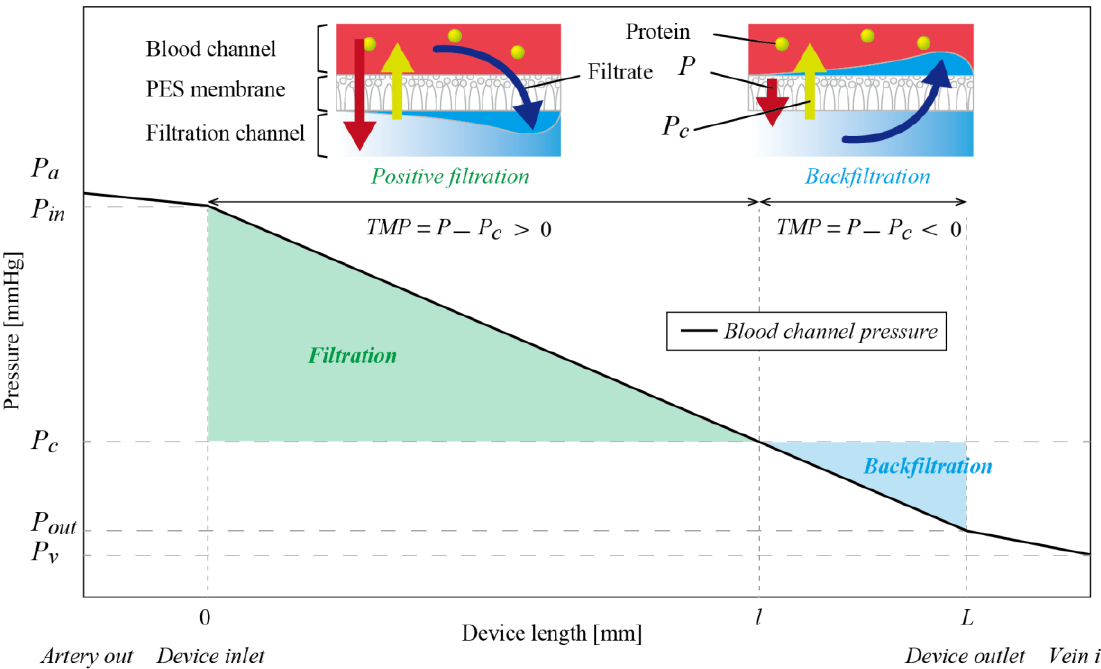
Figure 2. Pressure inside the blood channel with respect to position. The amount of filtrate is determined by the transmembrane pressure TMP , representing the difference between blood pressure 𝑃 and oncotic pressure 𝑃 𝑐 . When TMP is negative, backfiltration takes place and the total amount of filtrate decreases or even becomes zero. In humans, pressures in the artery and vein, 𝑃 𝑎 and 𝑃 𝑣 , are generally 90 – 130 mmHg and 5 – 10 mmHg, respectively, and the oncotic pressure 𝑃 𝑐 is 24 – 33 mmHg for a total protein concentration of 6.7 – 8.3 g/dL. Therefore, when only the hemofiltration device is connected to the artery and vein, TMP is negative and backfiltration takes place in some regions.